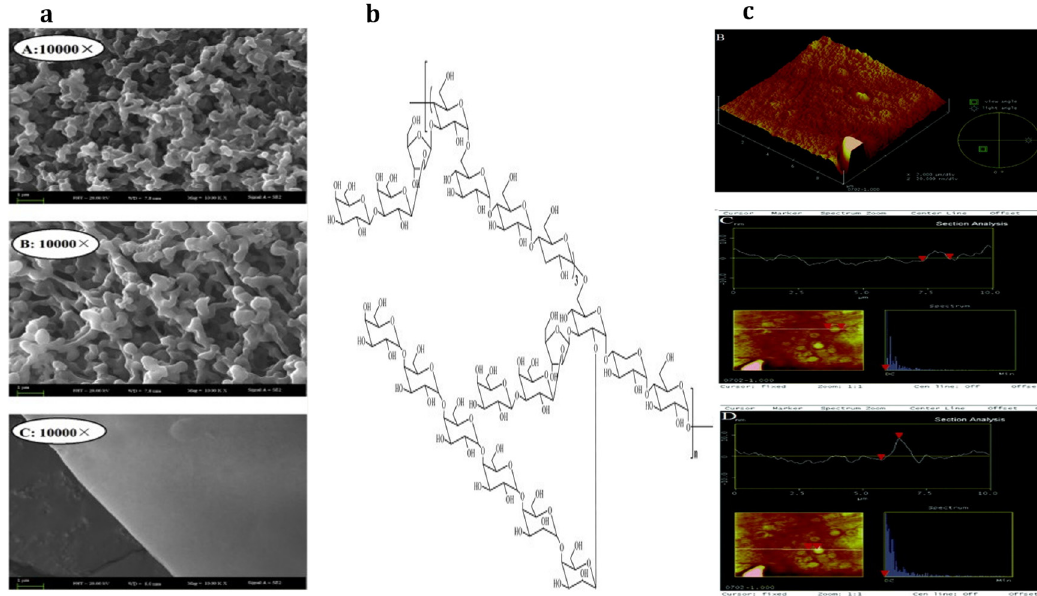
Figure 3. Triple helix structure of LPs. ( a ) SEM micrographs of polysaccharides from the seeds